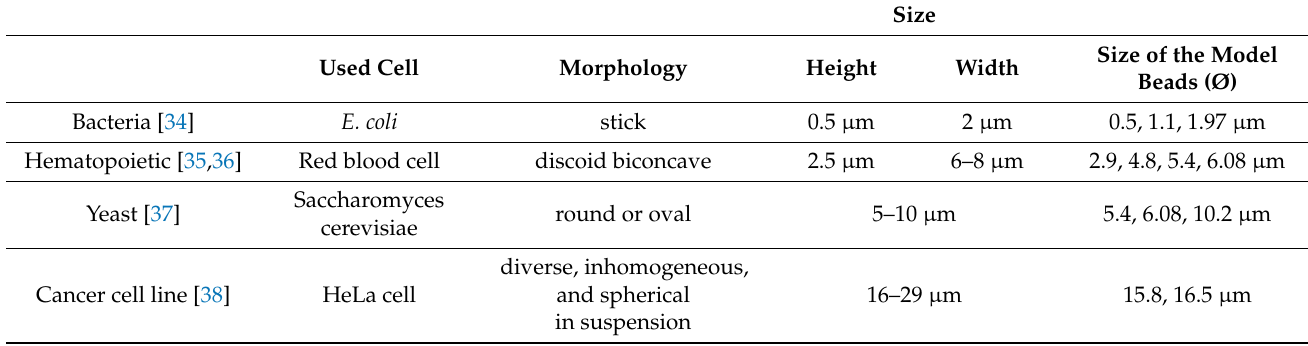
Table 2. The studied biological cells and the compared model bead sizes for lateral focusing in channel H25_W cr